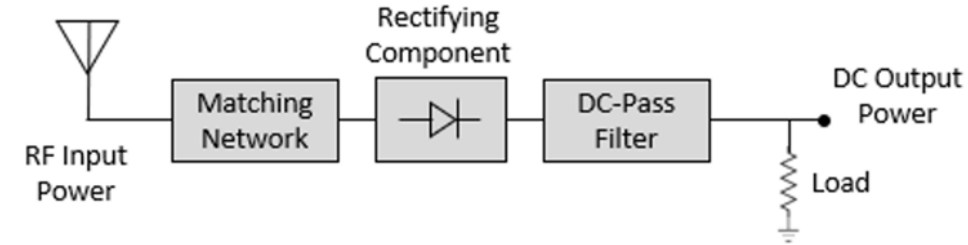
Figure 5. Block diagram of the rectifier circuit.